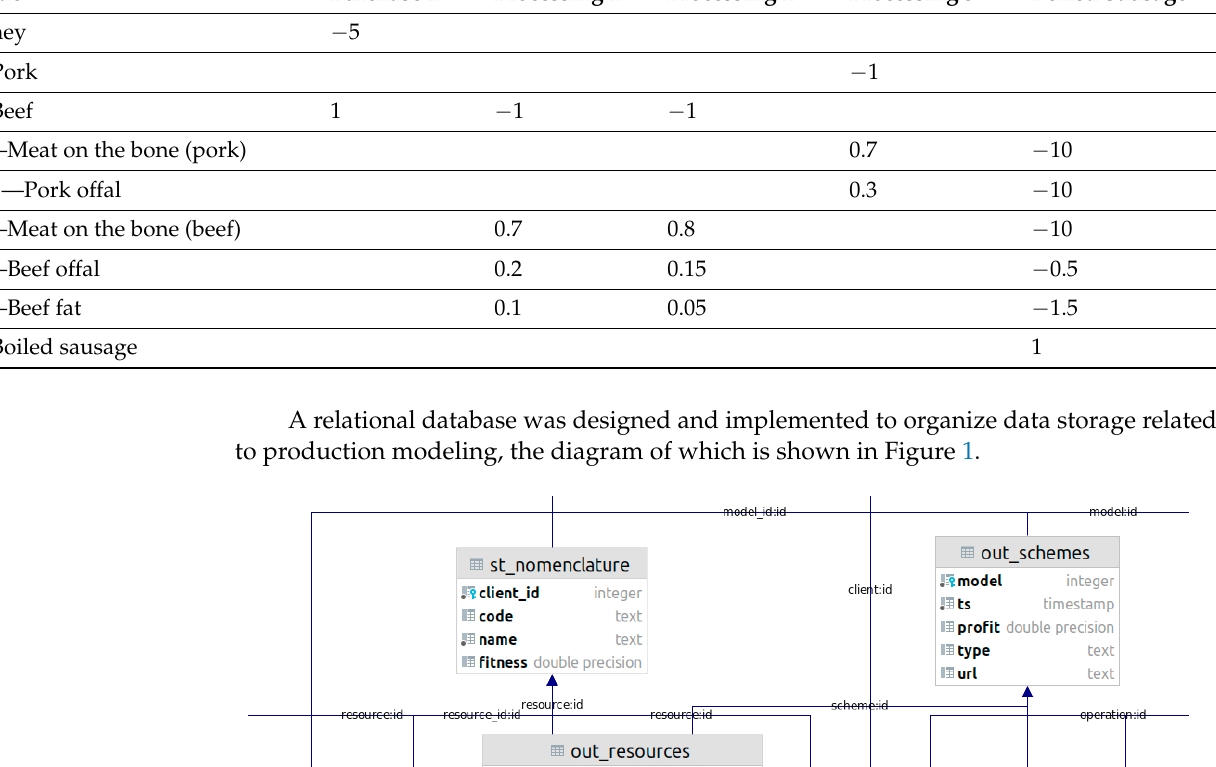
Table of technological limitations: This table contains the following characteristics for each manufacturing step: a.